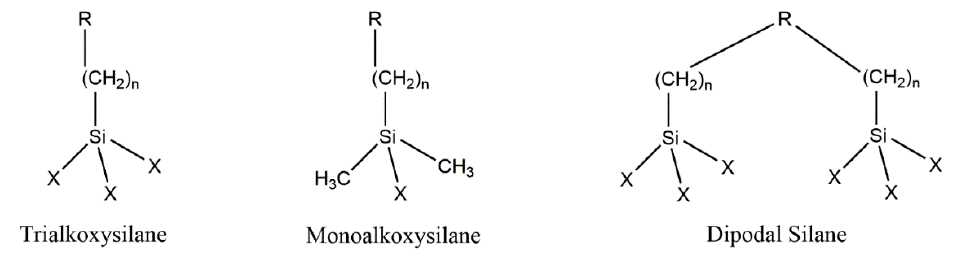
Figure 1. Chemical formula of silane coupling agents.